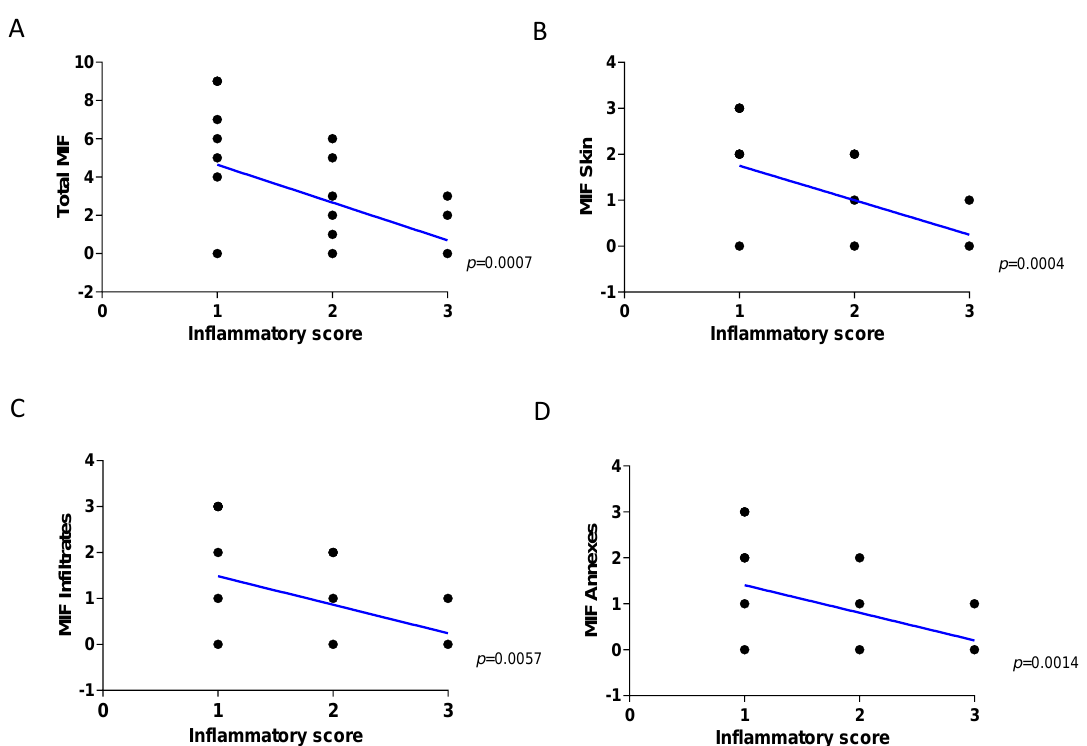
Figure 3. Correlation analysis between MIF expression and inflammatory score in DLE skin biopsies. Thirty-seven patients with DLE were recruited for this study. Biopsies were performed after a six-month wash-out period from topical treatments. Hematoxylin and eosin staining was used for histopathological evaluation. ( A ) Correlation between total MIF expression and inflammatory score. ( B ) Correlation between MIF expresses in the basal layer of the epidermis and the inflammatory score. ( C ) Correlation between MIF expression in the infiltrate and the inflammatory score. ( D ) Correlation between MIF expression in the annexes and the inflammatory score. Correlation analysis was performed using the non-parametric Spearman’s test.